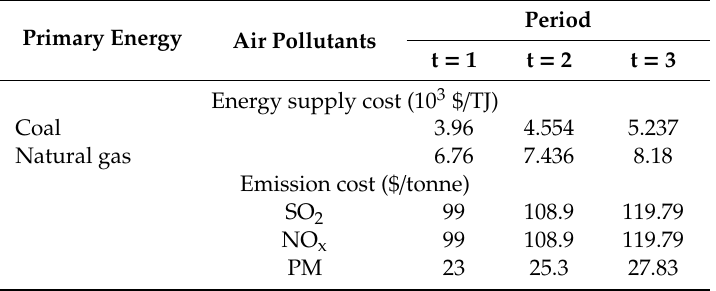
Table 1. Primary energy supply cost and emission cost.